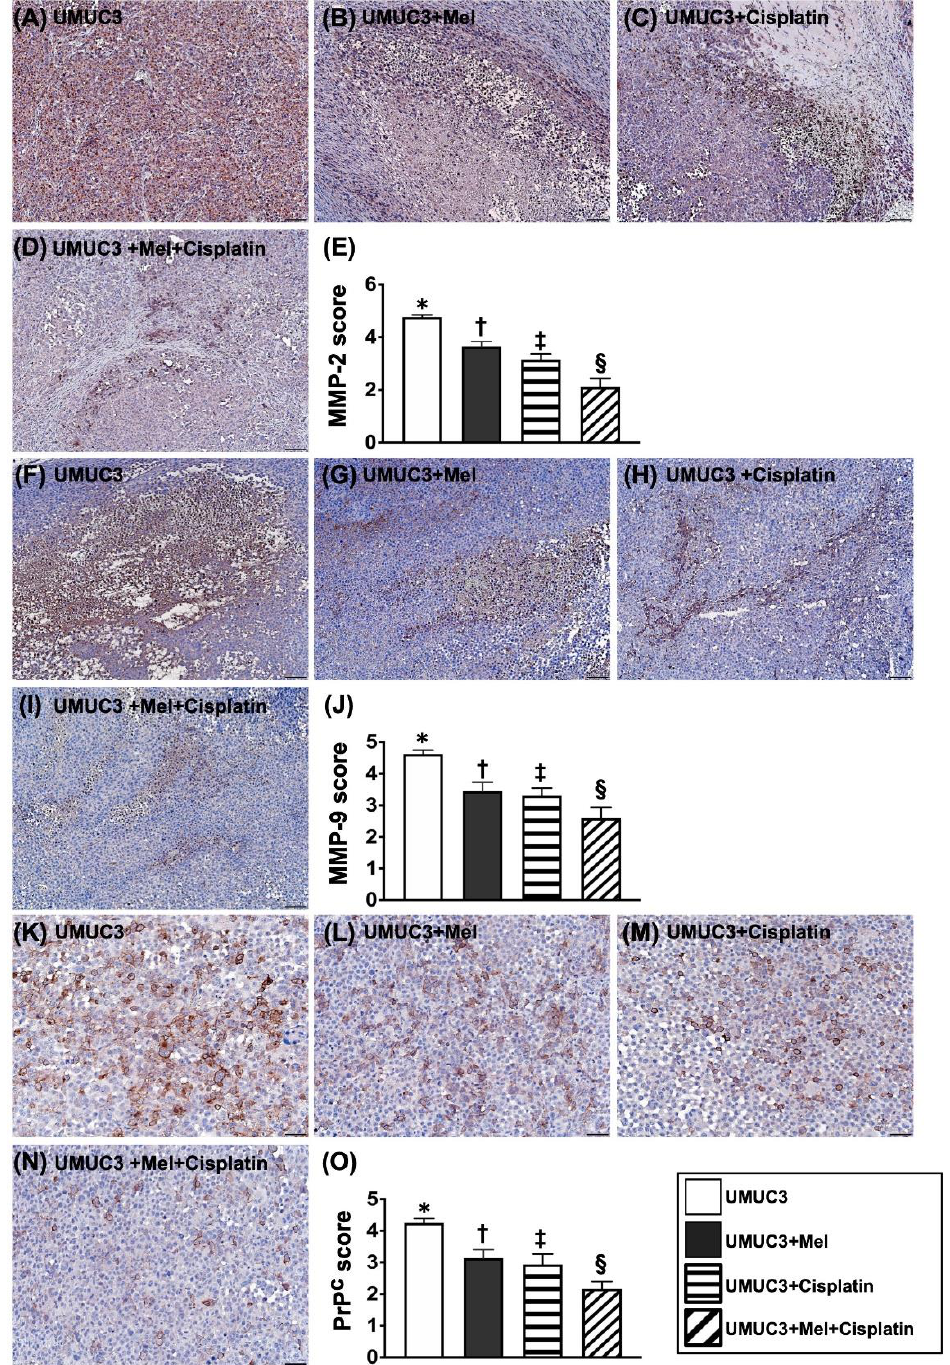
Figure 9. Cellular expressions of MMPs and PrP C in harvested tumors on day 28 after UMUC3 cell engraftment into nude mouse backs. ( A – D ) Demonstrating the microscopic finding (400 × ) of IHC staining for identifying MMP-2 (gray color) expression. ( E ) Analysis of expression of intensity (i.e., scores) of positively stained MMP-2, * vs. different symbols (†, ‡, and §), p < 0.0001. ( F – I ) Showing the microscopic finding (400 × ) of IHC staining for identifying MMP-2 (gray color) expression. ( J ) Analysis of expression of intensity (i.e., scores) of positively stained MMP-9, * vs. different symbols (†, ‡, and §), p < 0.0001. ( K – N ) Demonstrating the microscopic finding (400 × ) for identifying cellular prion protein (PrP C ) expression (gray color). ( O ) Analysis of expression of intensity (i.e., scores) of positively stained PrP C , * vs. different symbols (†, ‡, and §), p < 0.0001. Scale bars in right lower corner represent 20 µ m. n = 8 for each group. Mel =